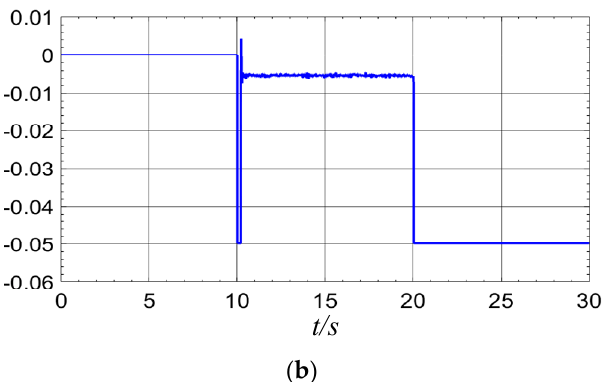
Figure 9. Waveforms without considering the polarity of I vd . ( a ) DC voltages. ( b ) The instruction value s 0 .